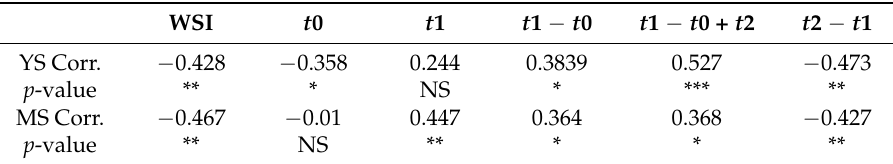
Table 3. Pearson’s correlations (coefficient correlation (Corr) and p -value) between annual tree ring width and annual water stress integral WSI, start of the growing season ( t 0), end of the growing season ( t 1), length of the spring growing season ( t 1 − t 0), length of the whole year growing including autumnal secondary growth ( t 1 − t 0 + t 2), and length of the summer growth break ( t 2 − t 1) for the mature stand (MS) and the young stand (YS). NS: non-significant, *: significant at p < 0.1, **: significant at p <